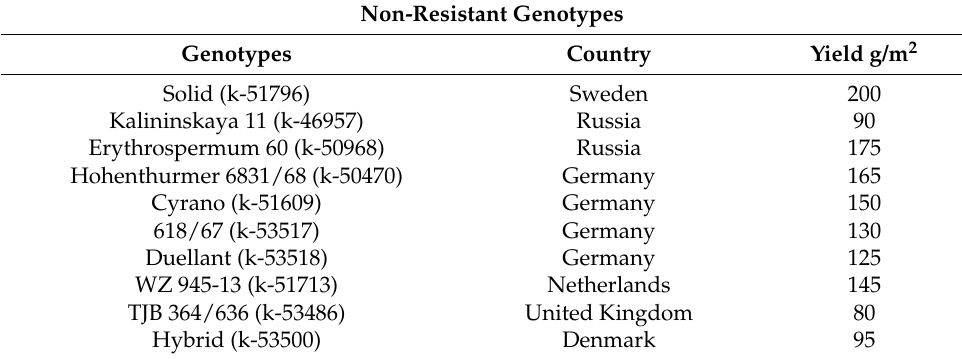
Table 6. Yield of the non-resistant genotypes